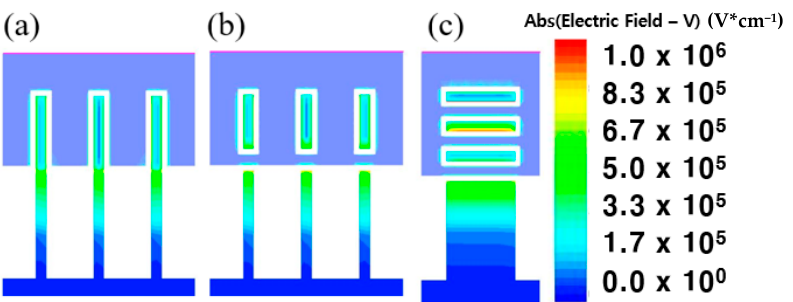
Figure 6. The input transfer characteristics of three devices (V DS = 0.7 V) for proximities of ( a ) 8 nm, ( b ) 5 nm, and ( c ) 3 nm. Please note that the doping concentration in the sub-channel region is set to 1 × 10 18 cm − 3 .